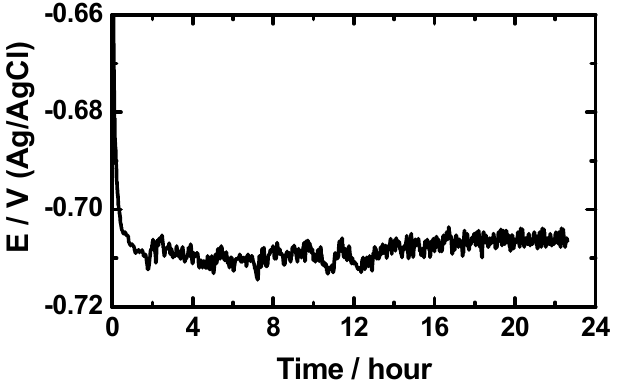
Figure 4. Change of the open-circuit potential with time for the cast iron electrode in the AGS solution.